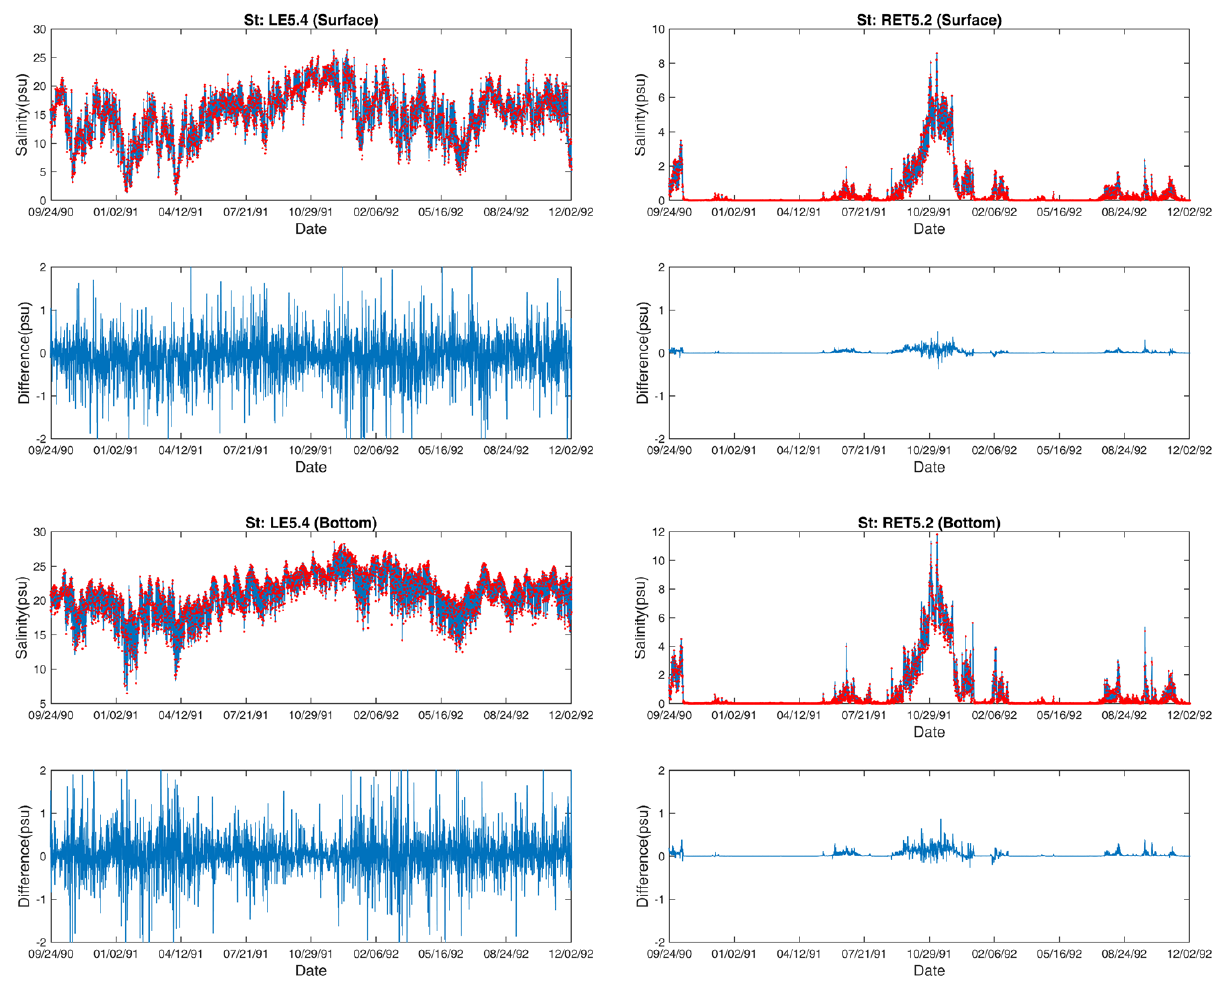
Figure 12. Comparison of change in salinity with wind forcing reductions by 10% at Stations LE5.4 and RET5.2, respectively, from 1990 to 2002 (red lines are the baseline condition; blue lines are the sensitivity run; the difference shows the difference between the sensitivity run and the baseline run).